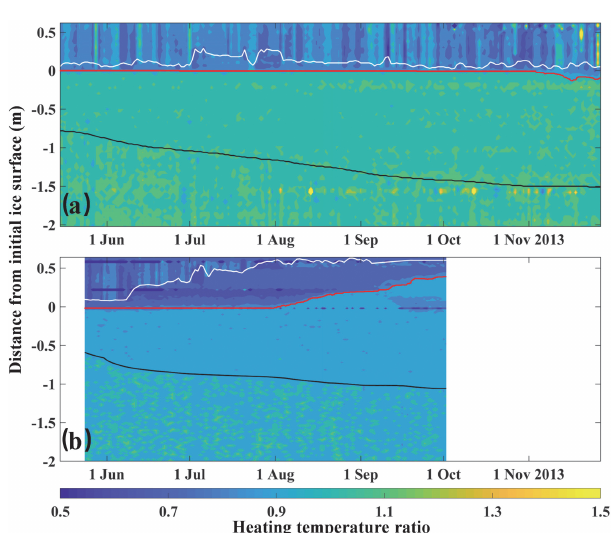
Figure 2. Profiles of the pulsed heating (HT) ratio after 30 and 120s observed by the (a) ZS2013a and (b) ZS2013b SIMBAs, with the white, red, and black lines denoting the snow surface, snow–ice in- terface, and ice bottom, respectively. The zero y value refers to the initial snow–ice interface at the buoy